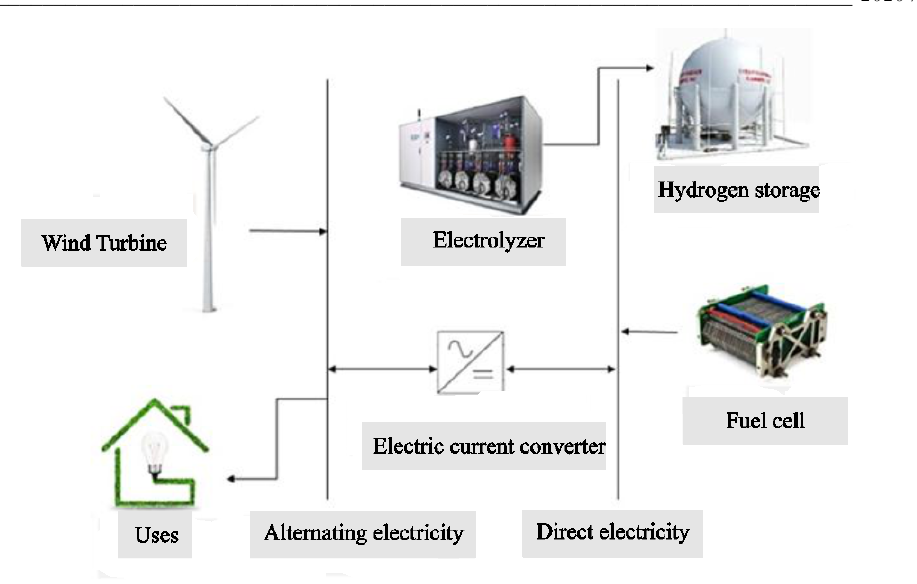
Fig. 1. Configuration of the proposed hybrid